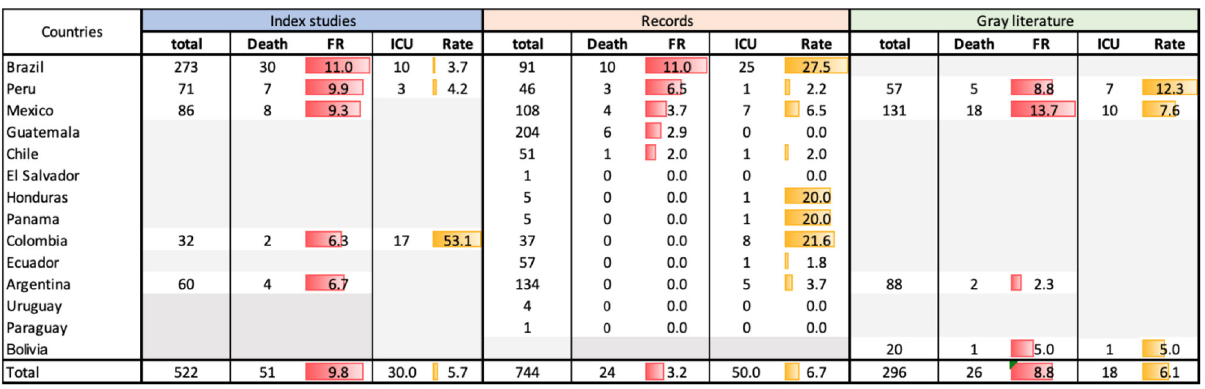
TABLE 2 Analysis including indexed studies, clinical records and others (gray literature) of mortality and SARS-CoV-2 in pediatric patients and cancer in Latin